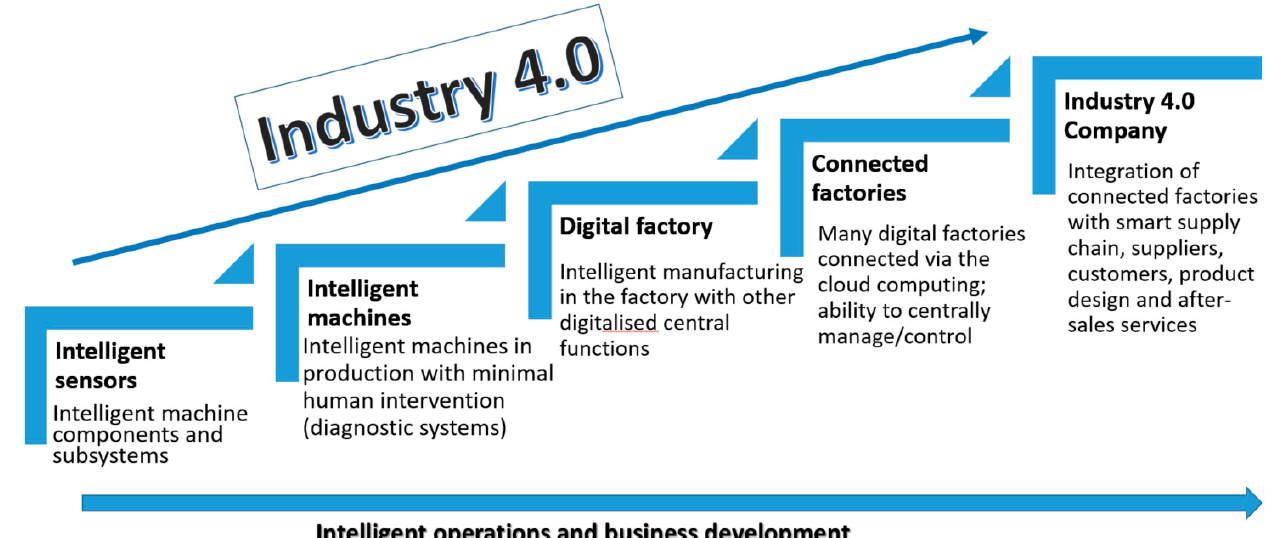
Figure 4. Development directions in Industry 4.0—what are businesses working towards? Source: own contribution based on [52].